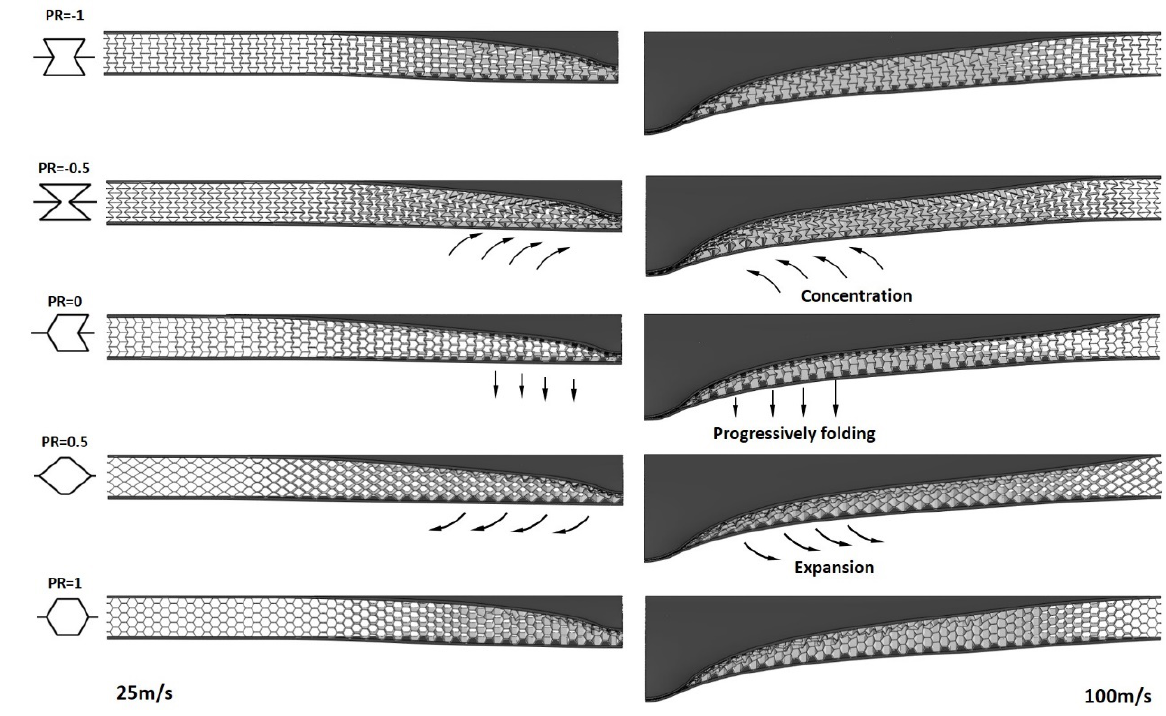
Figure 9: Poisson’s ratio on the deformation modes of sandwich